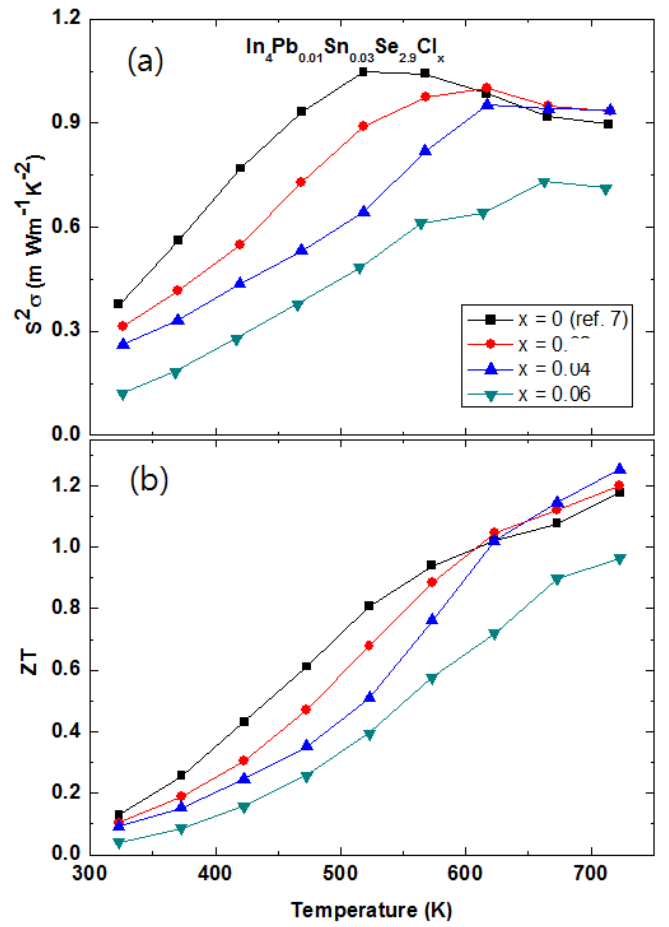
Figure 25. Temperature-dependent power factor S 2 σ ( a ) and ZT values ( b ) of the In 4 Pb 0.01 Sn 0.03 Se 2.9 Cl x ( x = 0.0, 0.02, 0.04 and 0.06) polycrystalline compounds